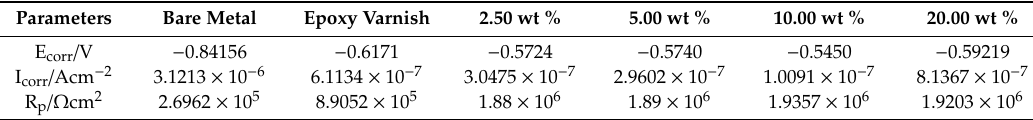
Table 2. Fitting results of Q235 steel coated with anionic coatings with different concentrations of cation exchange resin.